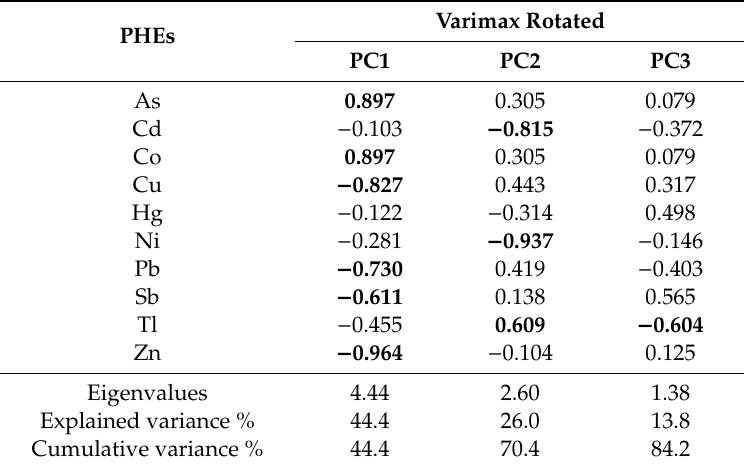
Table 4. Factor loading results obtained from the principal component analysis (PCA) for the cereals